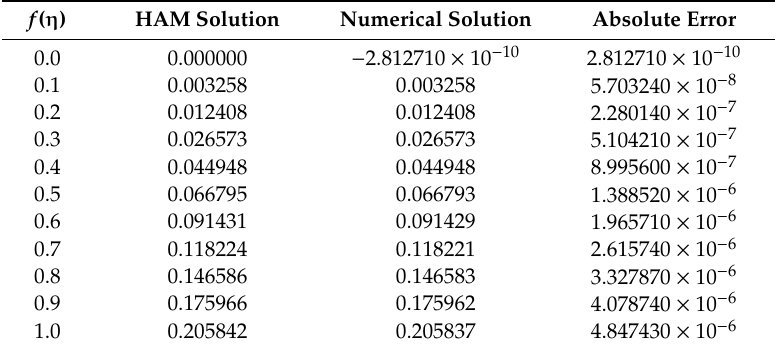
Table 1. Comparison of HAM and numerical solution for f ( η ).